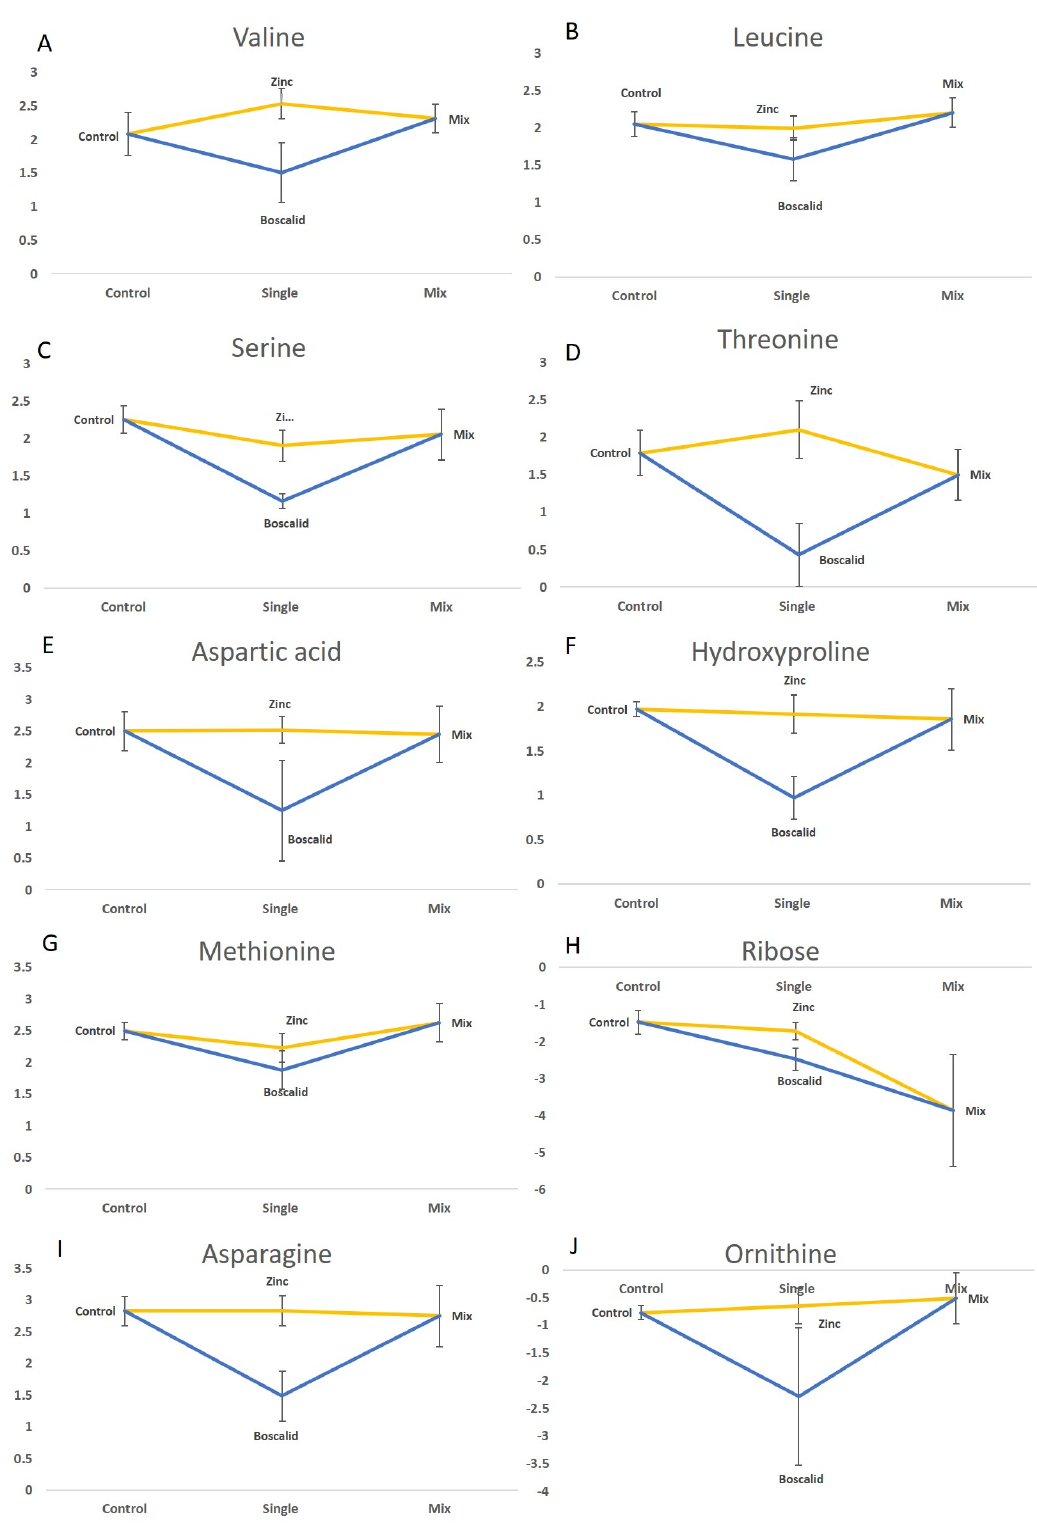
Figure 3. Line graphs of metabolites which significantly changed in abundance ( p < 0.05) following whole annelid ( S. aequisetis ) single exposure to zinc, boscalid and to their mixture. ( A ) Valine; ( B ) Leucine; ( C ) Serine; ( D ) Threonine; ( E ) Aspartic acid; ( F ) Hydroxyproline; ( G ) Methionine; ( H ) Ribose; ( I ) Asparagine; and ( J ) Ornithine. Y axis shows the peak area abundance for each metabolite from the GC-MS